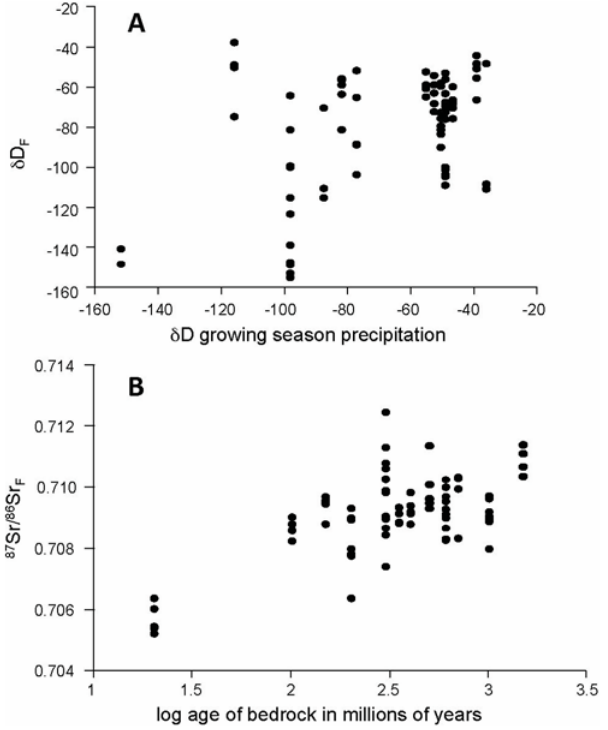
Figure 5. Predictors of d D and 87 Sr/ 86 Sr values in Tree swallow primary flight feathers. Each point represents an individual ( n =79). (a) d D growing season precipitation ( d D GS ) versus d D F (b) age of under lying bedrock versus 87 Sr/ 86 Sr F . d D GS data are from